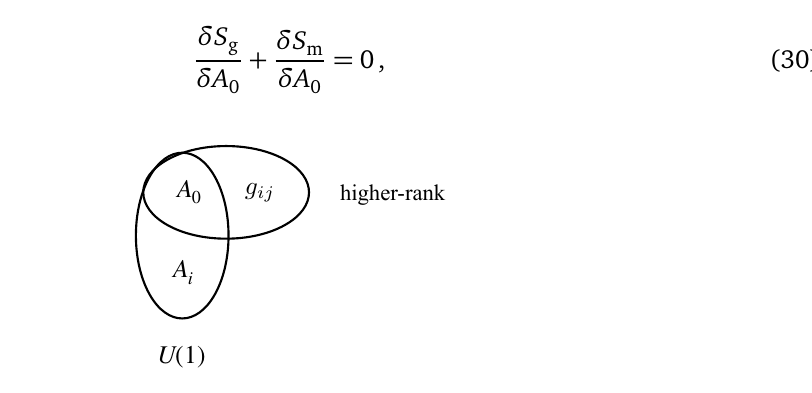
Figure 1: A is shared by two sets of gauge 0